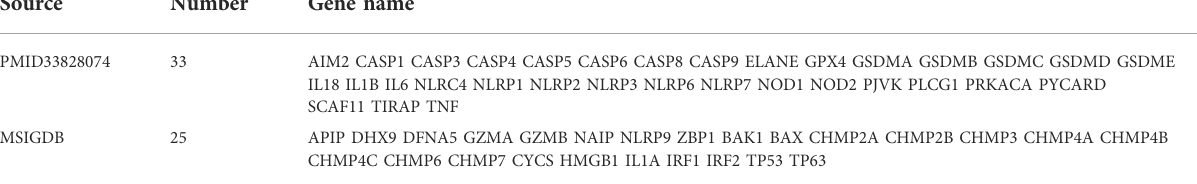
TABLE 2 Fifty-eight pyroptosis